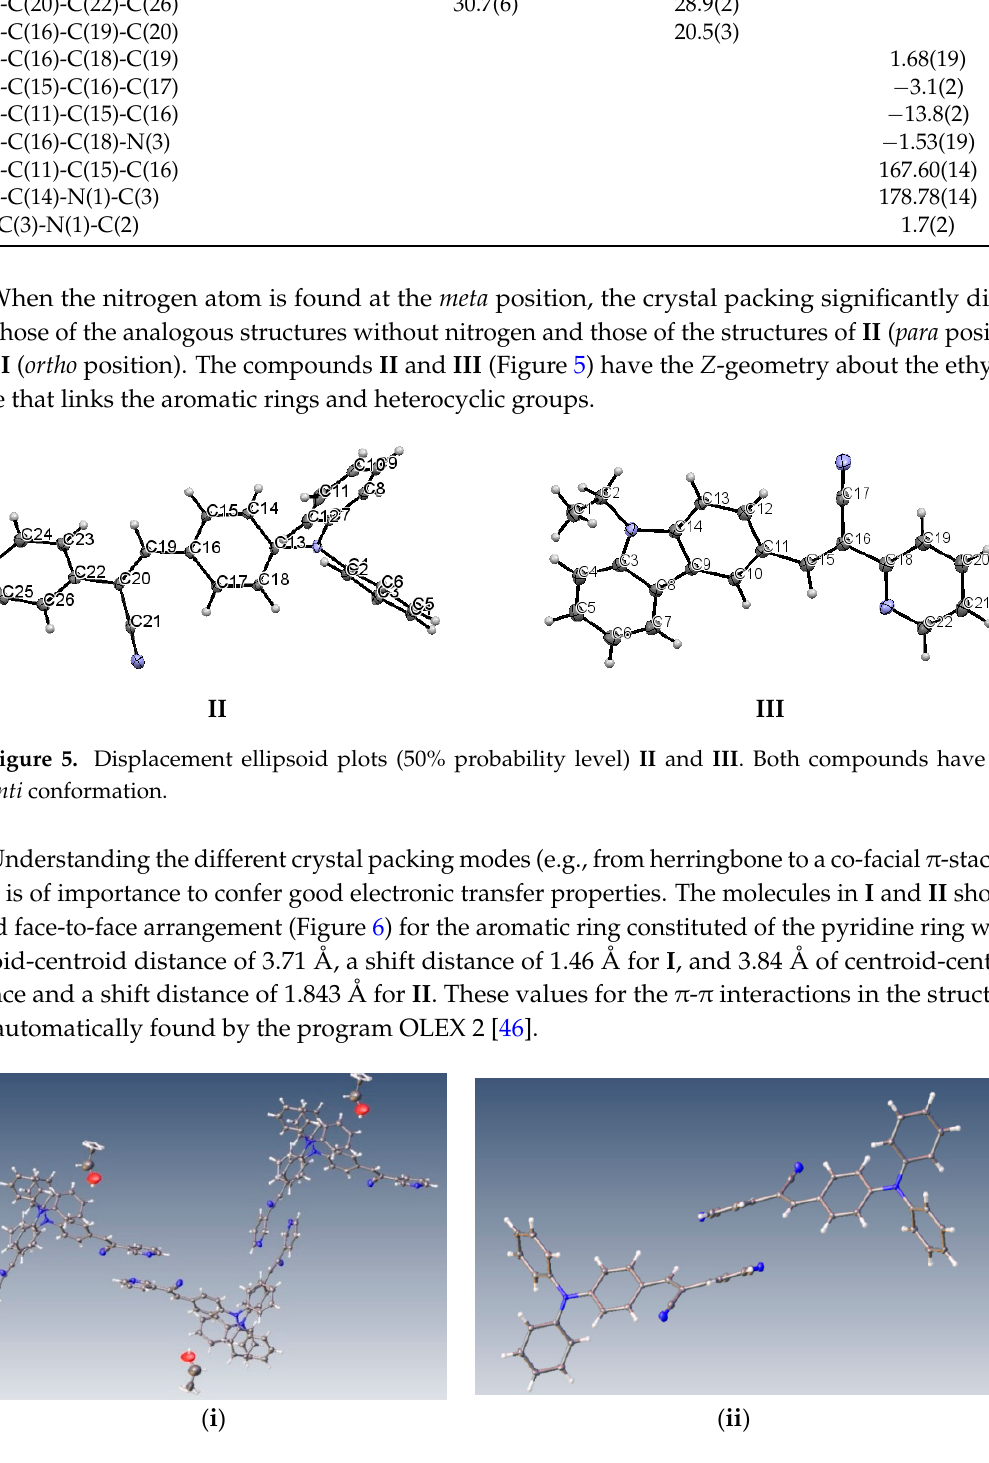
Figure 6. Perspective view of the packing structure of I ( i ) and II ( ii ) showing the strong π - π stacking interactions.